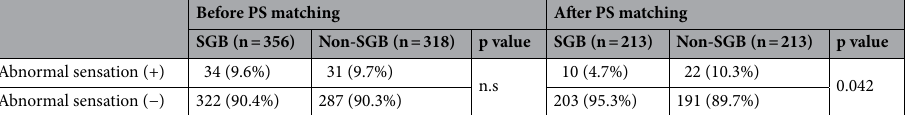
Table 3. Comparison of the incidence rate of abnormal sensations between the two groups. Data are presented as number of patients (percentage). PS propensity score, SGB stellate ganglion block, n.s . not